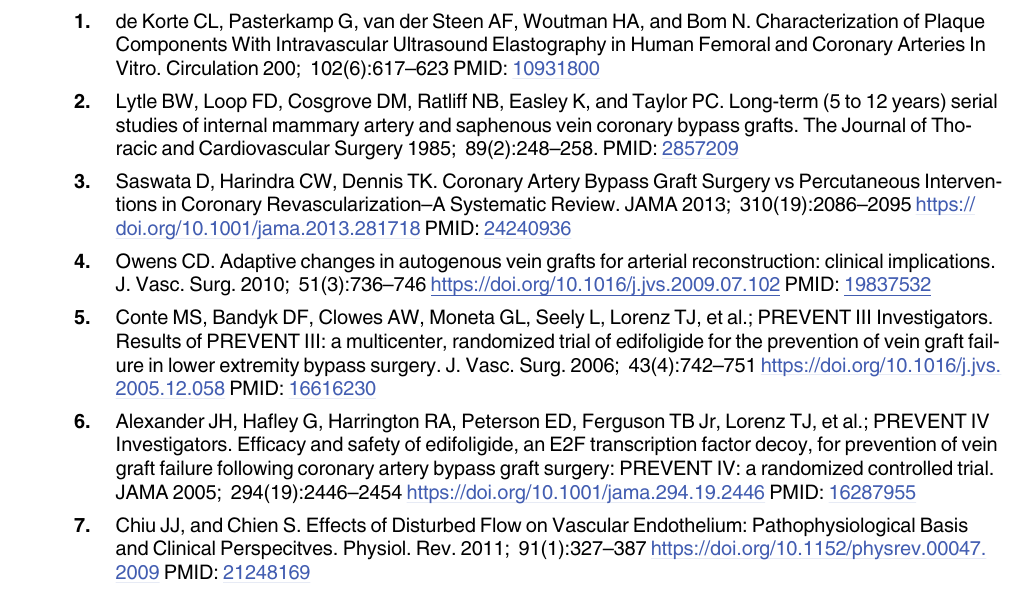
reported in the correspondent Excel sheet. Each event is tracked at 0, 0.08 hours and 1,3,7,14,28 days through different biological measures and under low, high, and intermediate shear stress conditions: i) Proliferation Rate and ii) Apoptosis Rate is evaluated by measuring the mitotic/apoptotic density in cells/mm 2 ; iii) Matrix Growth Rate is evaluated by measuring the Matrix Area Change Rate in mm 2 /day; iv) EEL Growth Rate (cellular movement) is evalu- ated by measuring the EEL Area Rate of Change in mm 2